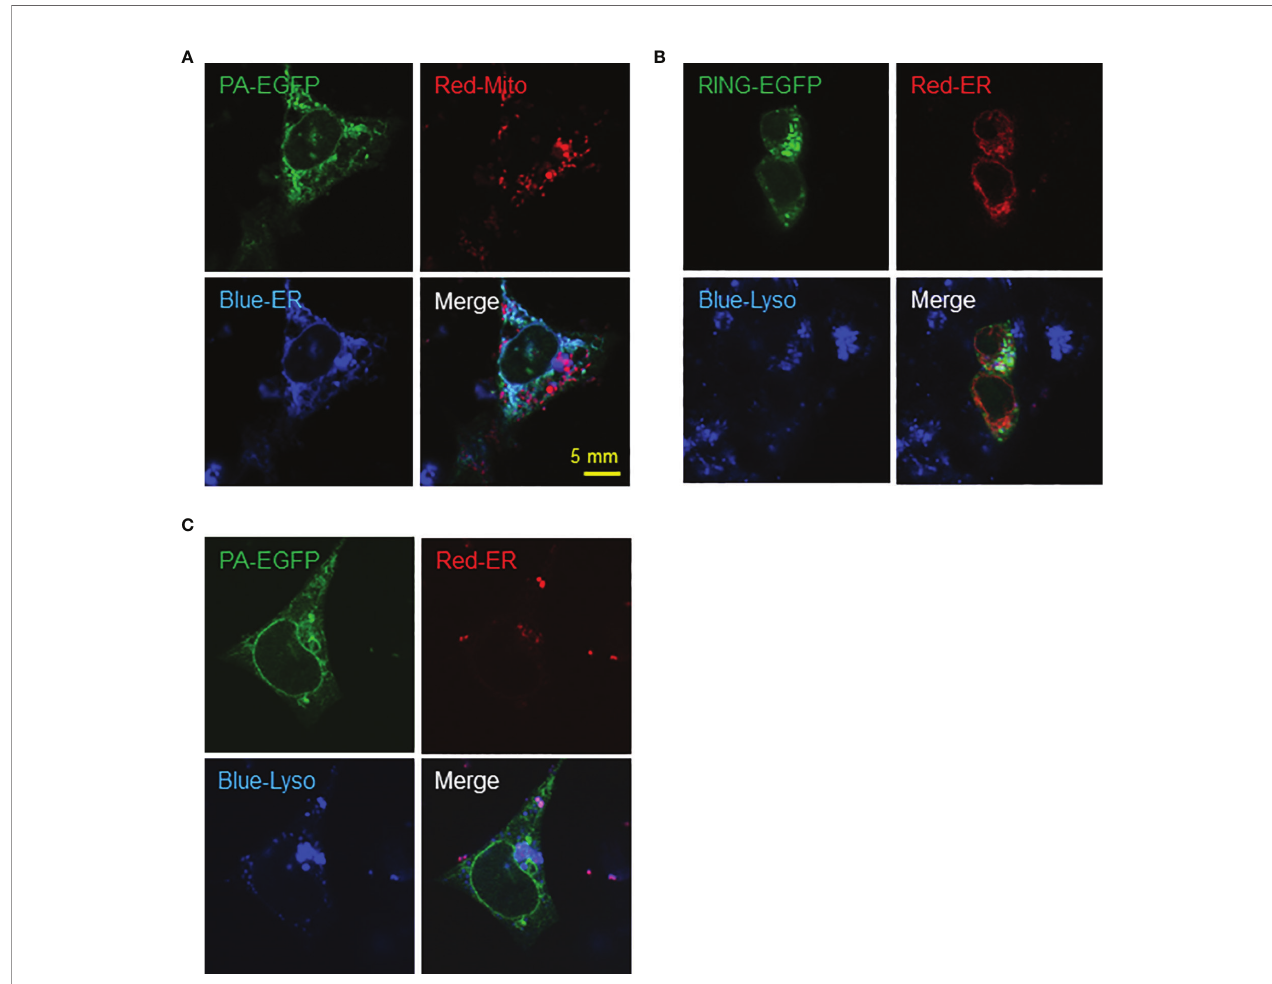
FIGURE 8 | F9 cells as a potential model for studying RNF149 function. (A) RNF149 is co-localized with ER by PA domain but not the mitochondria. PA-type RNF149 isoform is co-transfected with ER marker (blue) and mitochondria marker (red). (B) PA-domain potentially co-localizes with ER while RING-domain is co- localized with lysosomes. RING-EGFP vector is co-transfected with ER marker (red) and lysosome marker (blue). (C) PA-EGFP vector is co-transfected with ER marker (red) and lysosome marker (blue). Representative images